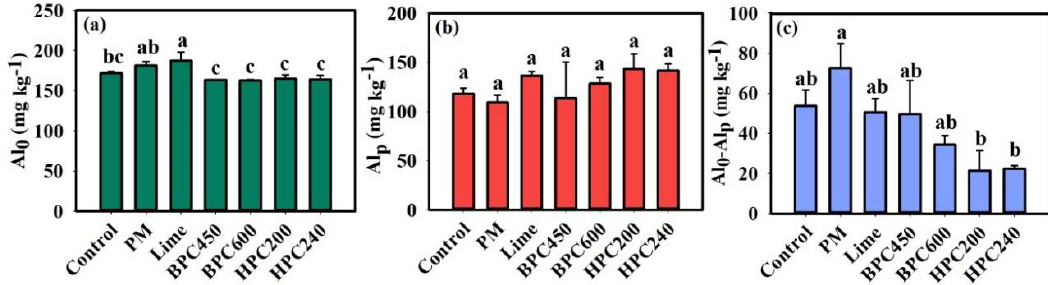
Figure 2. Al extracted by acid ammonium oxalate (Al 0 ) ( a ) and by sodium pyrophosphate (Alp) ( b ); inorganic non-crystalline Al (Al 0 -Al p ) ( c ). Means followed by the same letter are not significantly different ( p < 0.05) using Tukey’s HSD test.